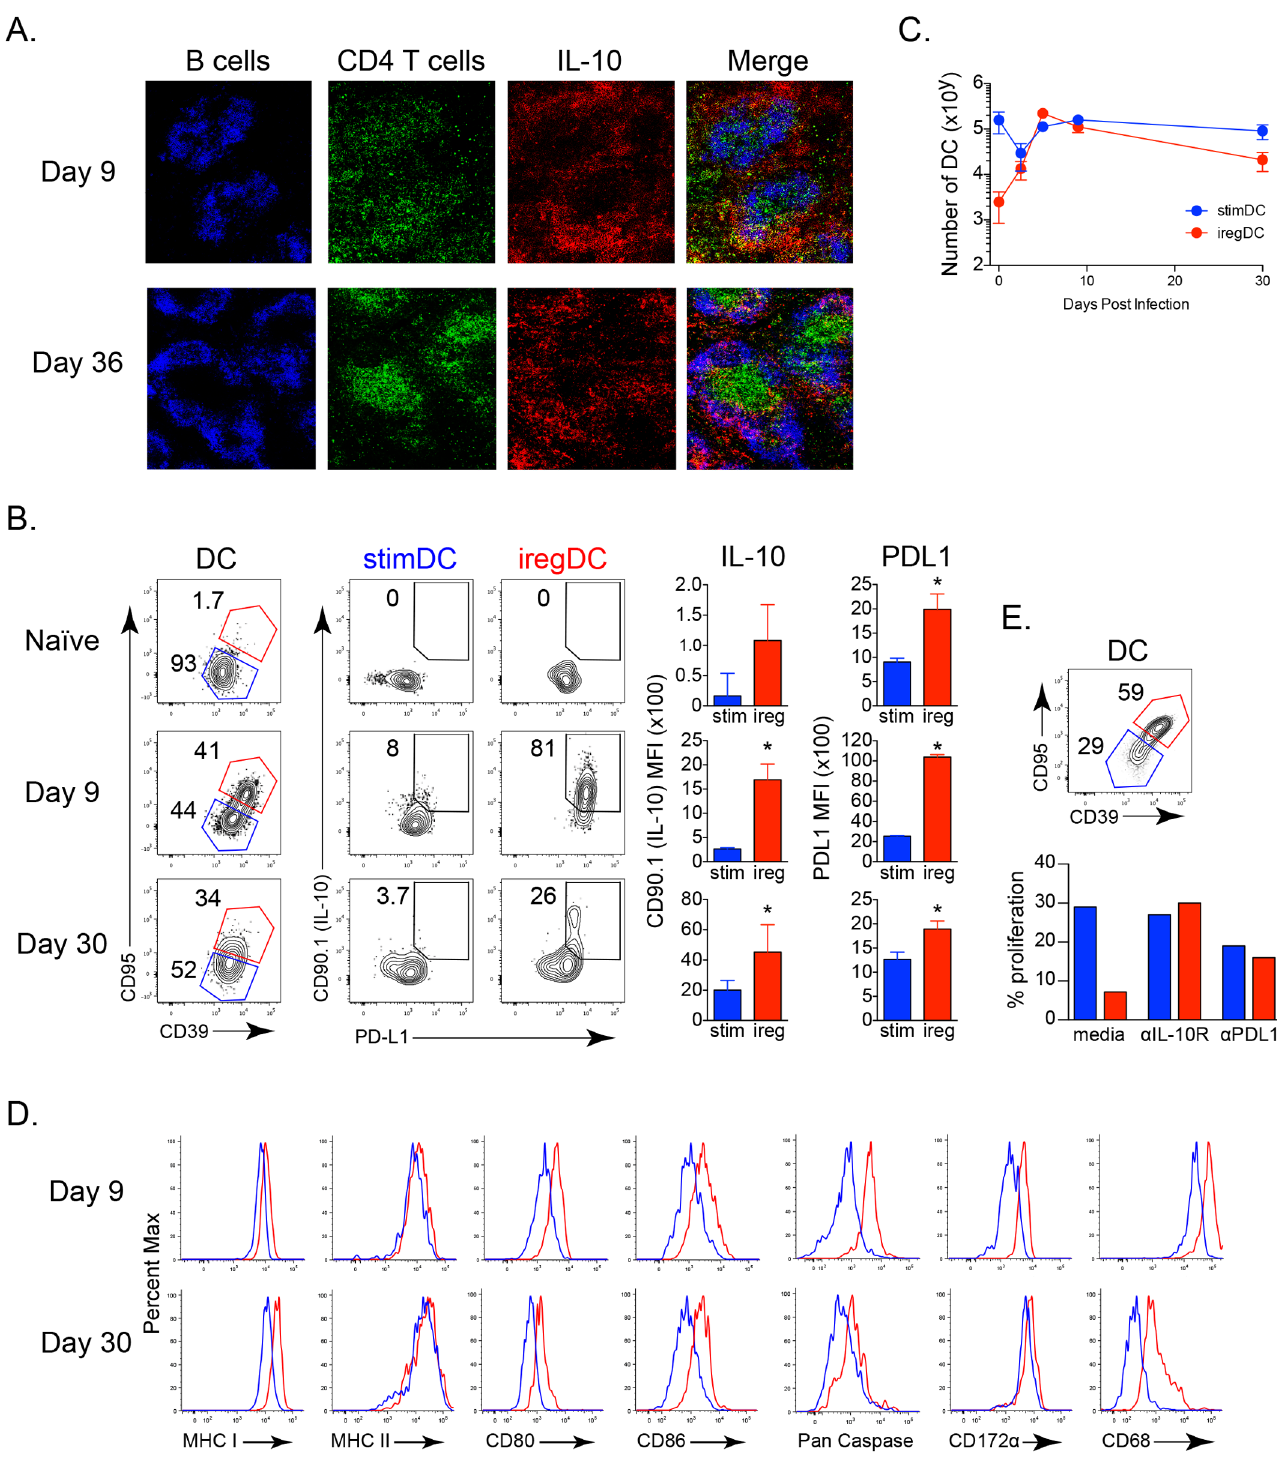
Fig 1. In vivo localization and identification of immunoregulatory DCs during viral persistence. A. Sections from IL-10 reporter mice infected with LCMV-Cl13 for 9 or 36 days were stained for B cells, CD4+ T cells, and CD90.1 (IL-10) and visualized at 10x magnification. B. CD39 and CD95 expression on splenic CD11b+ DCs from naive IL-10 reporter mice or IL-10 reporter mice infected with LCMV-Cl13 for 9 or 30 days and their corresponding expression of CD90.1 (IL-10) and PDL1 within the iregDC (red) and stimDC (blue) populations. Bar graphs indicate the geometric mean fluorescence intensity (MFI) of CD90.1 (IL-10) and PDL1 expression by iregDCs (red) and stimDCs (blue). DC are characterized as being viability dye-, CD45+, Thy1.2-, NK1.1-, Ly6G-,